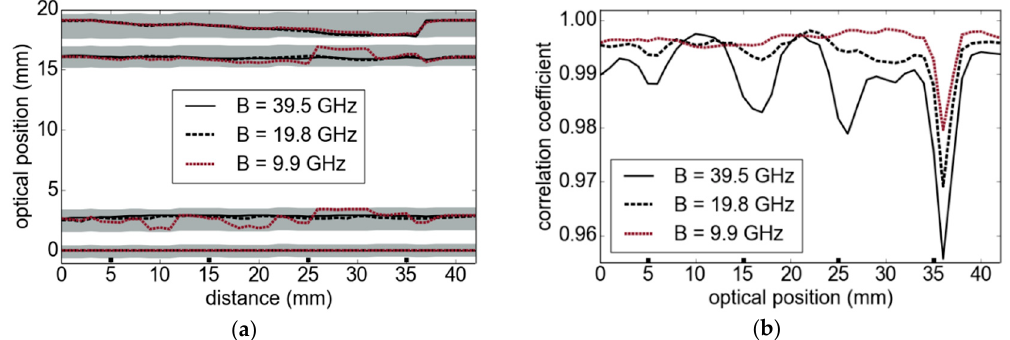
Figure 9. Stepped tube section: ( a ) the number of samples and, hence, the bandwidth is reduced; ( b ) correlation coefficient for the 4th reflection in dependence of the modulation bandwidth,